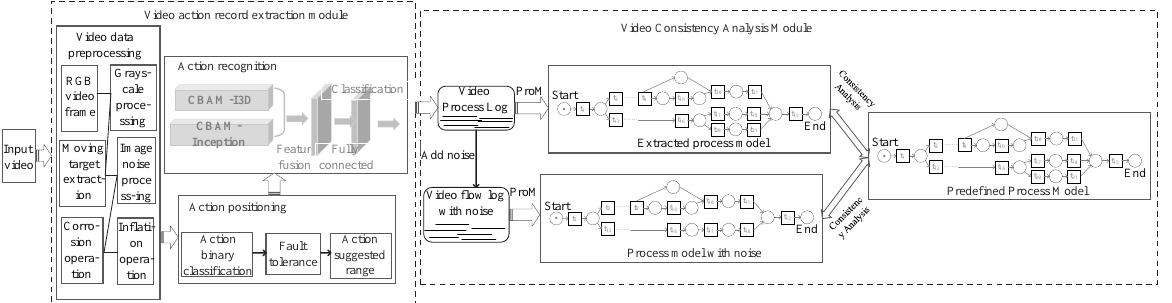
Figure 1. The framework of our approach.